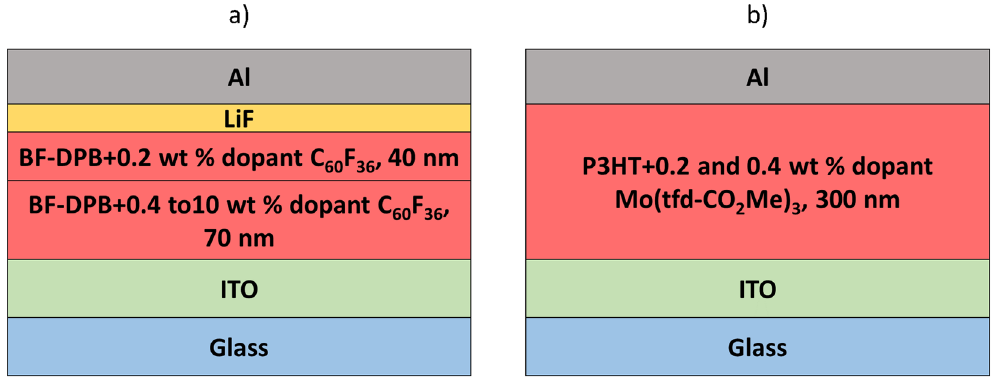
Figure 4. Schematic picture of the device structure of ( a ) vacuum-evaporated thin film devices with a BF-DPB active layer doped with